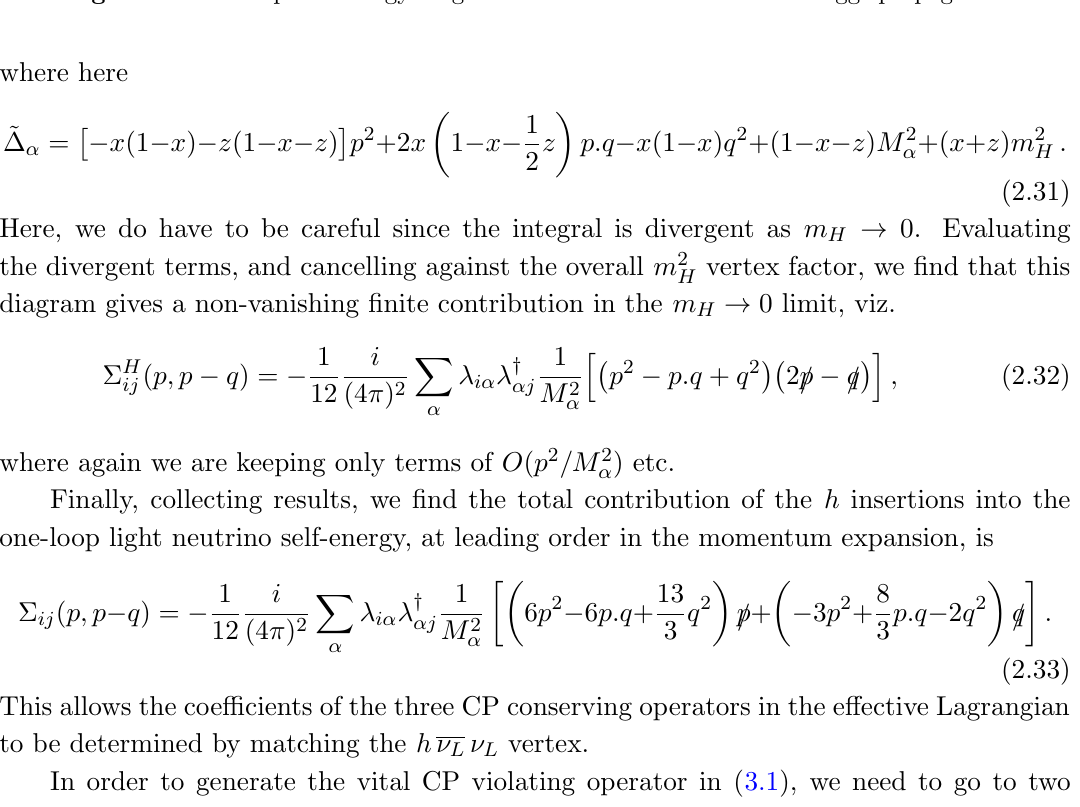
Figure 8 . One-loop self-energy diagram with an h insertion on the Higgs